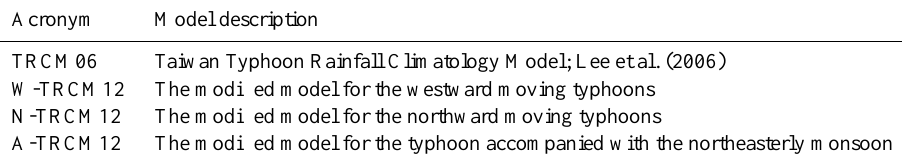
Table 1. The abbreviation for the